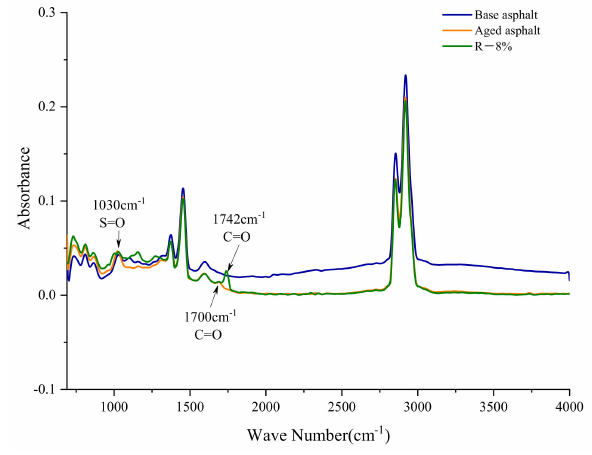
Figure 13. FTIR images of different asphalt